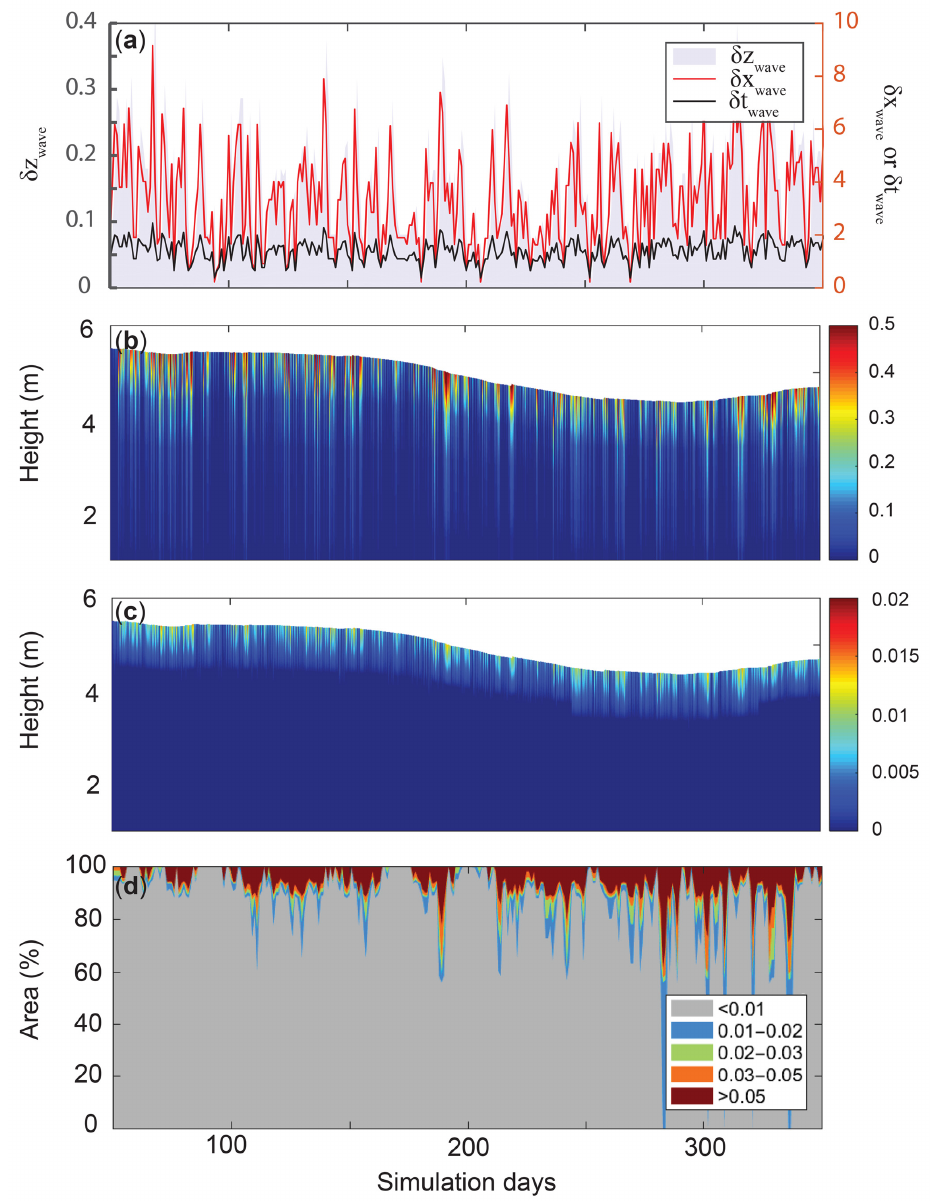
Figure 15. Simulation from Woods Lake, Australia, showing (a) time series of surface wave properties, (b) orbital velocity, U orb (ms − 1 ), (c) layer mean velocities, U m (ms − 1 ), and (d) lakebed area percentage within each of the five depicted shear stress categories (based on τ i , Nm − 2